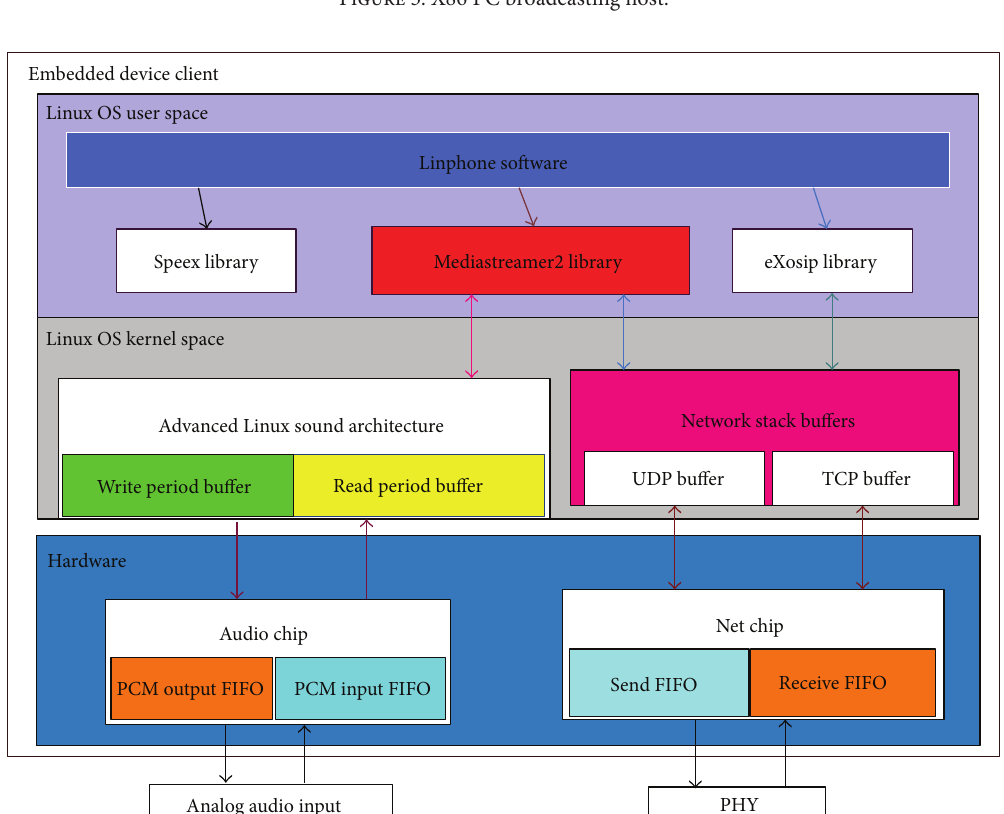
Figure 4: ARM-based embedded